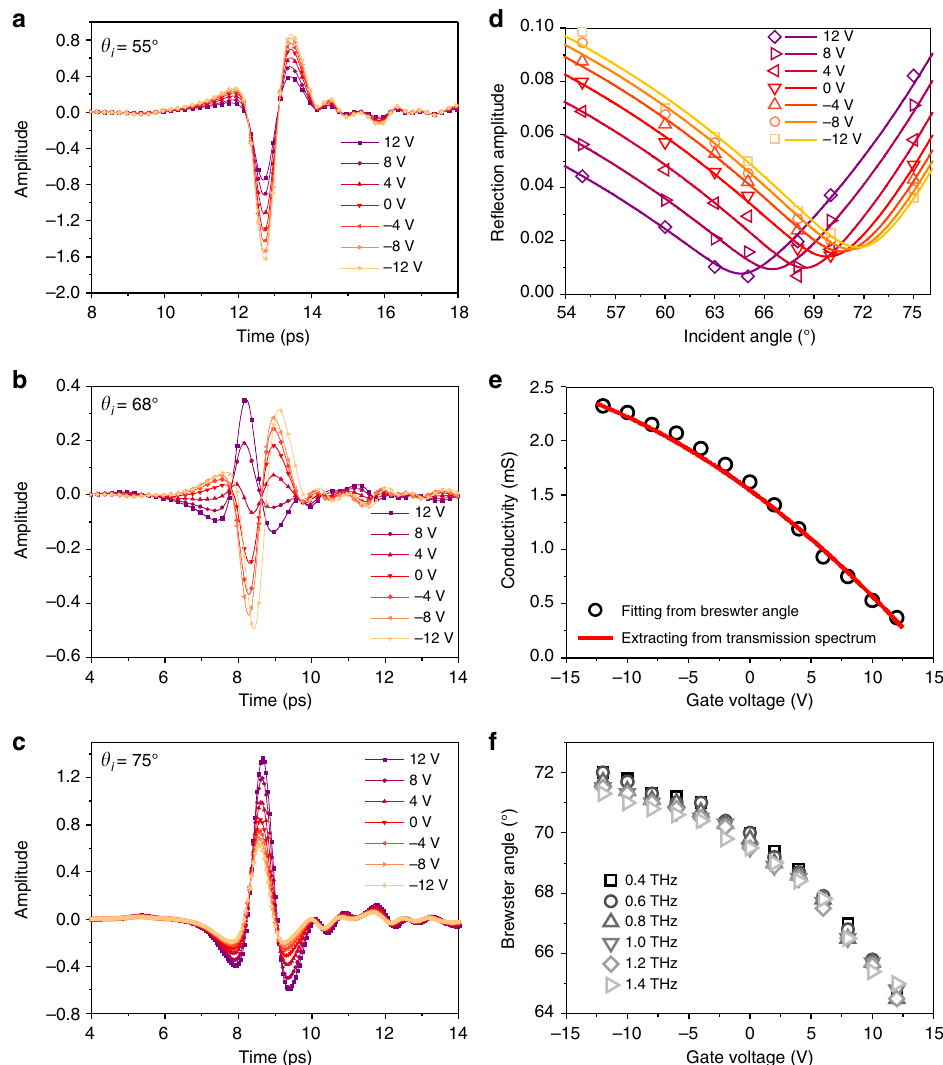
Fig. 2 Controlling the Brewster angle by adjusting the conductivity of graphene. The re fl ection THz time-domain signal under different gate voltages with incident angles of ( a ) 55, ( b ) 68, and ( c ) 75°. d Re fl ection amplitude as a function of incident angle for the frequency of 0.8 THz. Open symbols represent the experimental amplitude and solid lines show the curve fi tting according to Eq. (1). e The fi tted conductivity for different gate voltages at the frequency of 0.8 THz (open circles) and the conductivity extracted from the transmission spectrum (red line). f The Brewster angle as a function of gate voltage at different